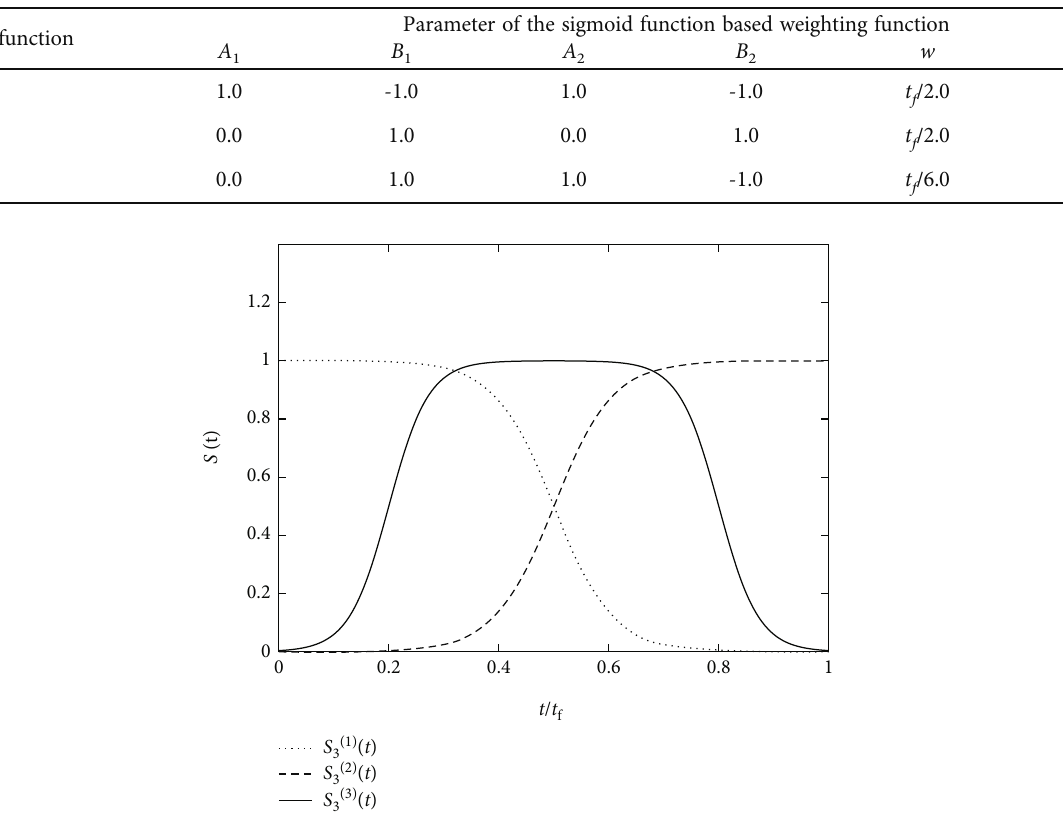
Table 3: Di ff erent parameters for S